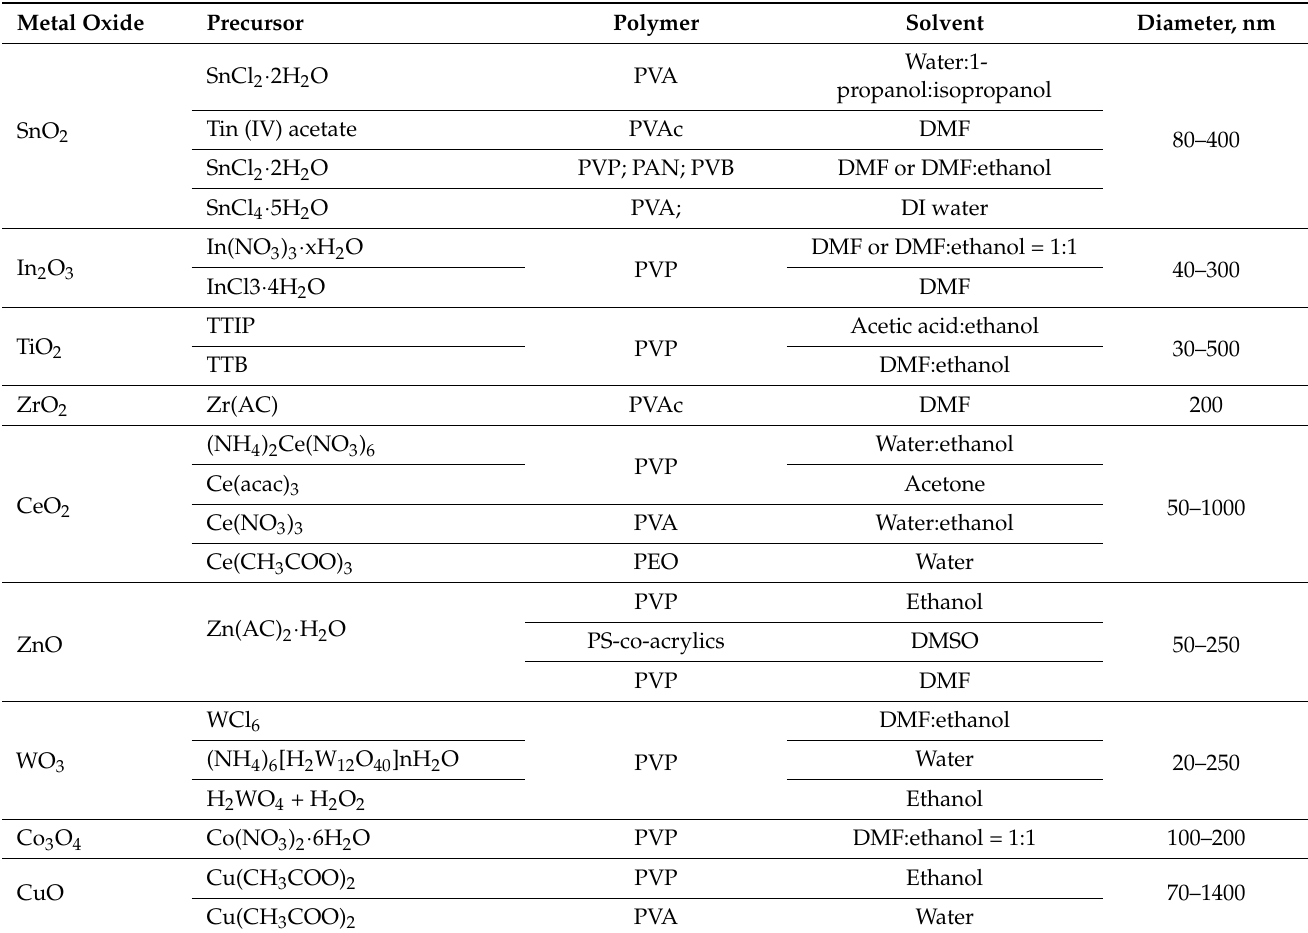
Table 4. Examples of solvents and precursors used to make metal oxide-based